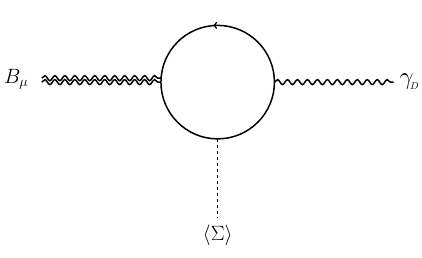
Figure 3 . Loop for dark photon-photon mixing. The double wavy line indicates the non-abelian origin of the hypercharge boson. The fermionic line stands for some representation with GUT and dark U(1) D